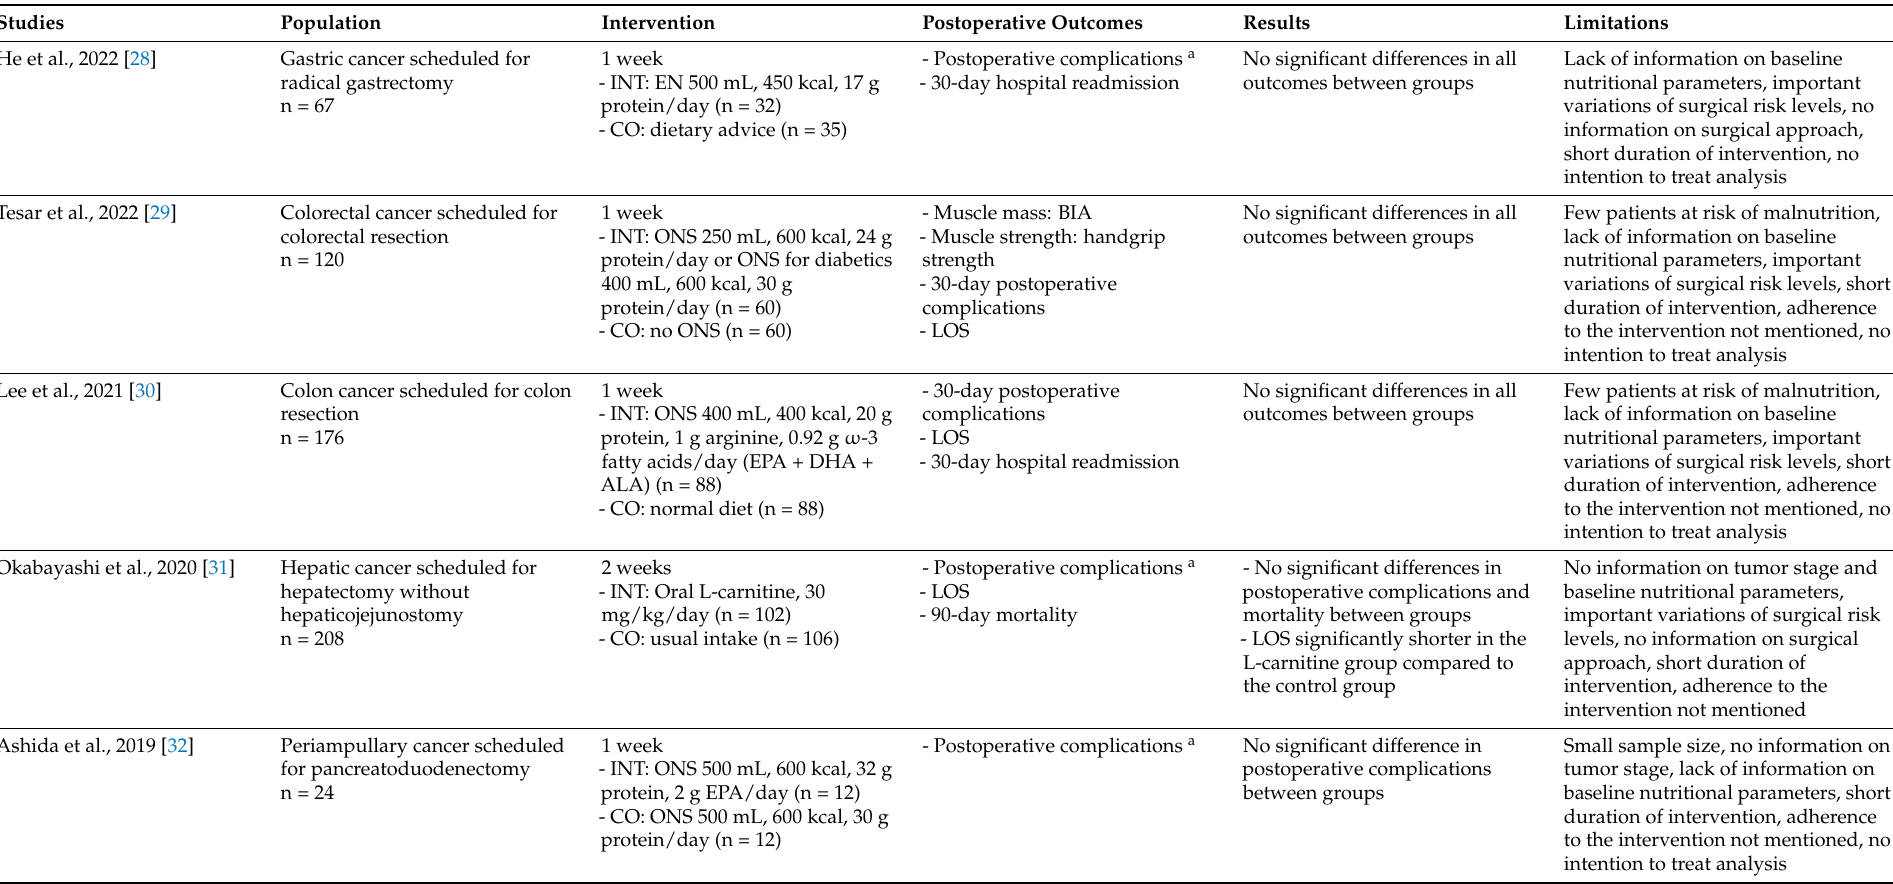
Table 1. Nutritional interventions before surgery in patients with gastrointestinal